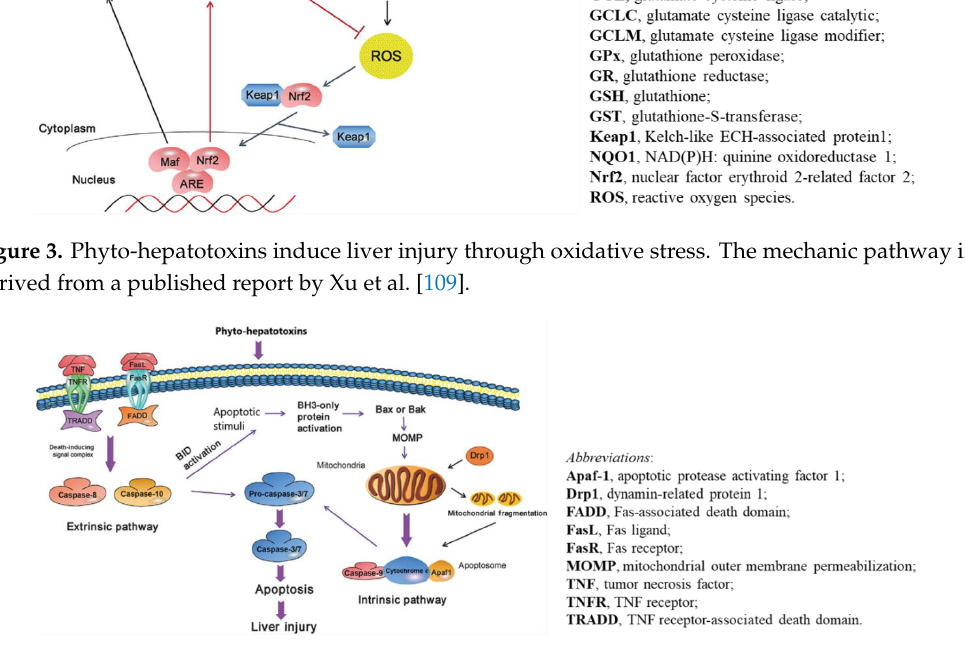
Figure 4. Phyto-hepatotoxins induce extrinsic (death receptor) and intrinsic (mitochondrial) apoptotic pathways. The pathways are adapted from the report of Xu et al. [109].